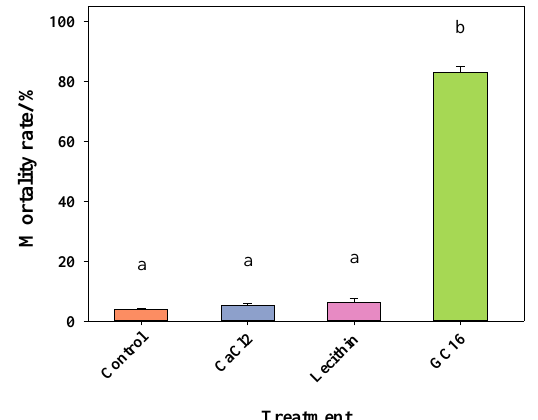
Figure 2. The mortality rates for 24 h of T. pueraricola under GC16 and its components. Component 1 is Calcium chloride (CaCl 2 ), and Component 2 is Lecithin. Data are expressed as mean ± SE. Different lowercase letters represent significant differences among different treatments at p < 0.05 based on one- way ANOVA in Tukey’s HS D test.